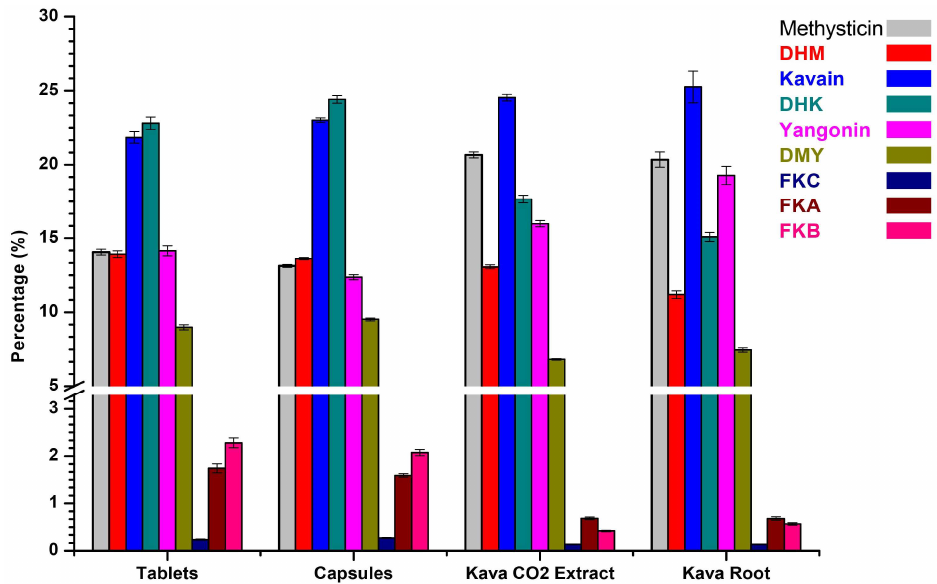
Figure 5. The profiles of kavalactones and flavokavains for kava products.